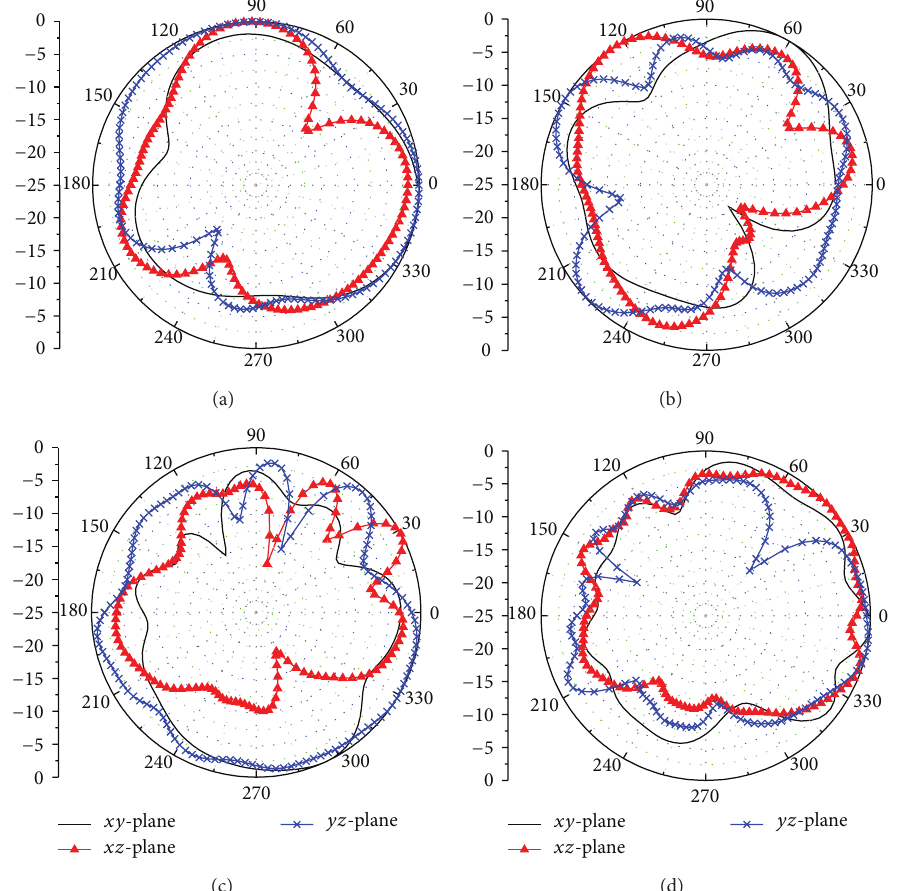
Figure 7: Measured 2D radiation patterns: (a) 900 MHz, (b) 1900 MHz, (c) 2500 MHz, and (d)